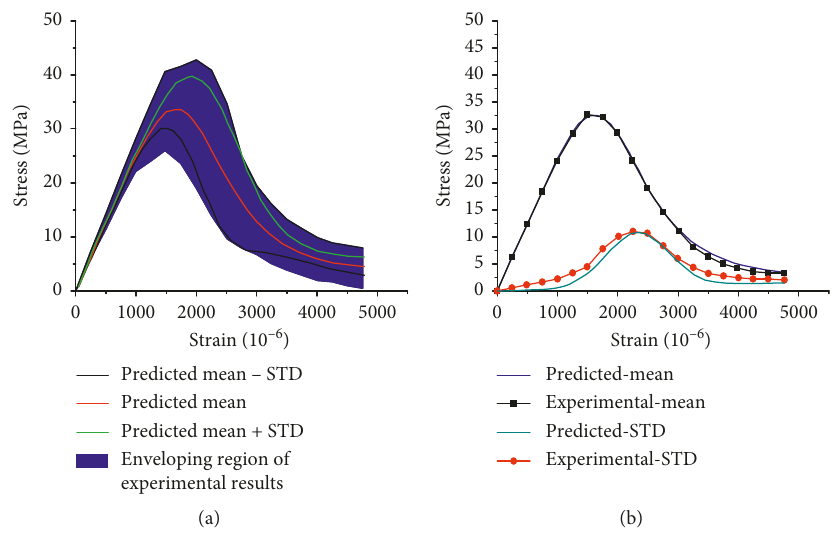
Figure 5: Comparison of experimental and predicted stochastic stress-strain response of SCC under uniaxial monotonic compression. (a) Enveloping region of σ − ε . (b) Mean and STD of σ − ε .